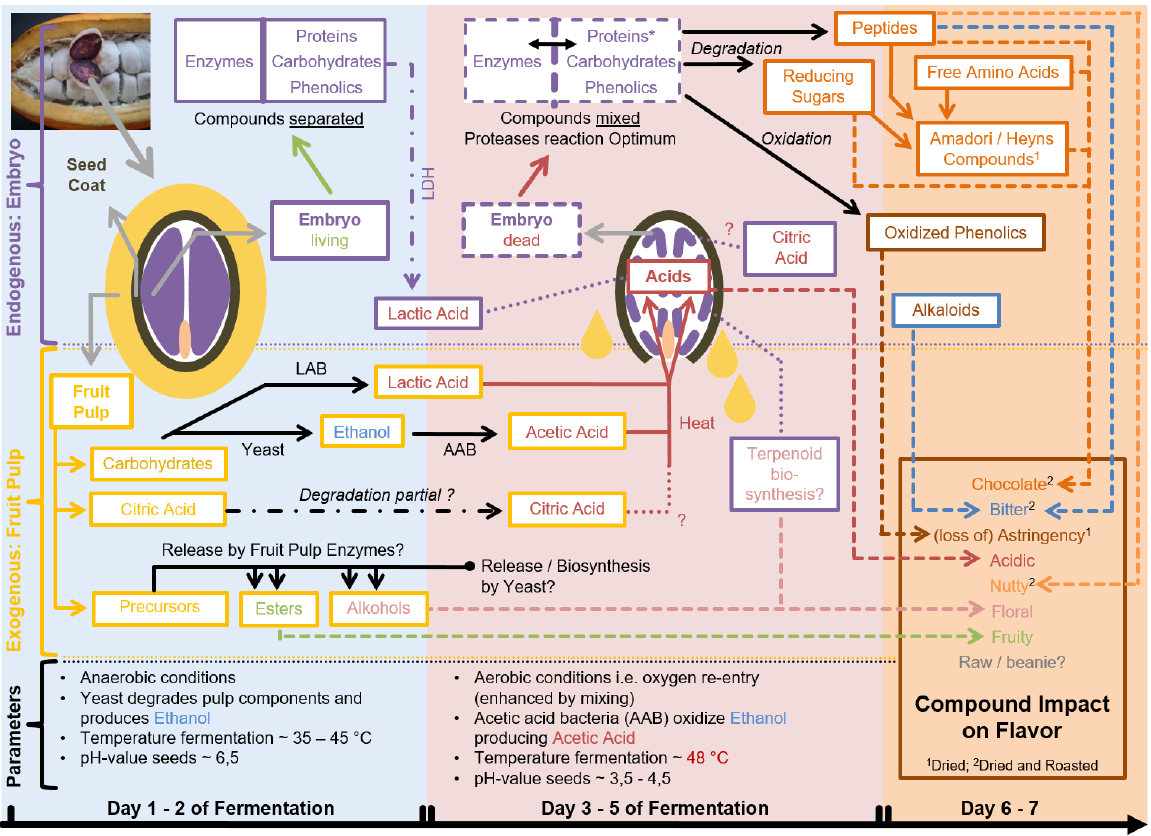
Fig. 4: Physicochemical networks during standard cocoa fermentation. Based on the discussions with Reinhard Lieberei, Christina Rohsius and Silke